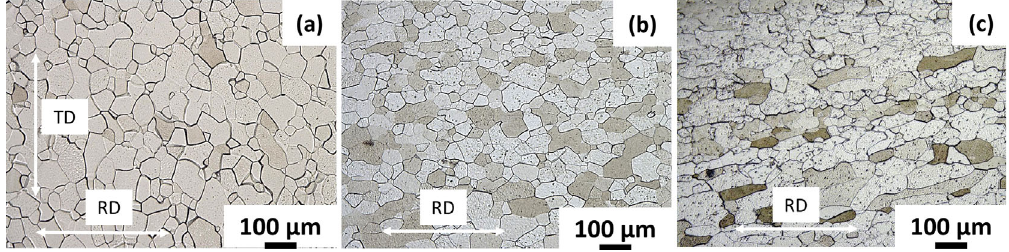
FIG. 8. Microstructure of Niobium (Ningxia) used for EHF of half-cells: (a) surface of the metal sheet (RD indicates the rolling direction and TD the transversal direction), (b) through thickness microstructure (Ningxia), (c) through thickness microstructure (Plansee).